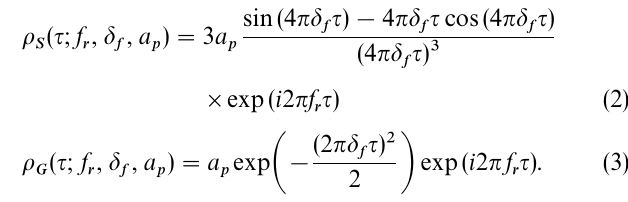
Fig. 5 the parameters of the fit models are plotted. All of the parameters exhibit a rather good